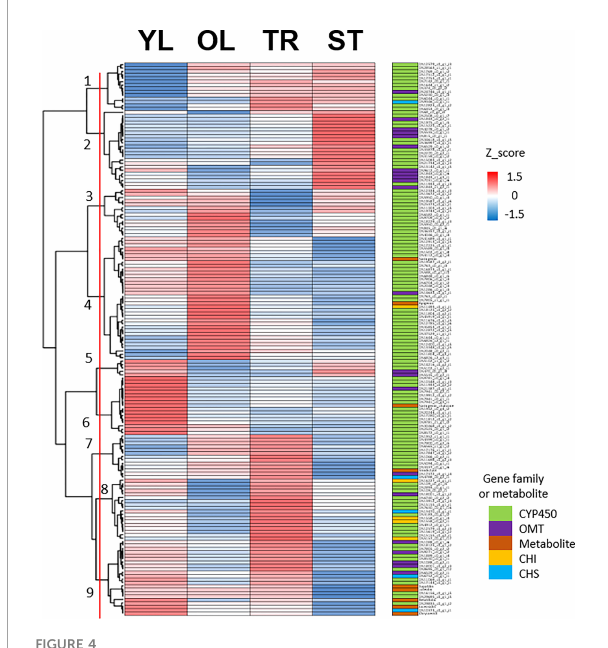
FIGURE 4 Clustering analysis of 153 fl avonoid-related genes and 9 metabolites. Hierarchical clustering heat map of 153 fl avonoid-related gene expression and content of 9 metabolites from four different tissues based on the z-score of either gene: Log 2 (normalized count+1) or metabolite: Log 2 (amount of metabolite+1). Color classi fi cation for gene family and metabolite is as follows, CYP450; Cytochrome P450 (light green), OMT; O -methyltransferase (violet), Metabolite includes naringenin, chalcone, naringenin, apigenin, eriodictyol, luteolin, chrysoeriol, batatifolin, eupatilin and jaceosidin (amber), CHI; Chalcone- fl avanone isomerase (yellow), CHS; Chalcone synthase (cyan). YL represents young leaves, OL represents old leaves, TR represents trichomes, and ST represents trichome-removed